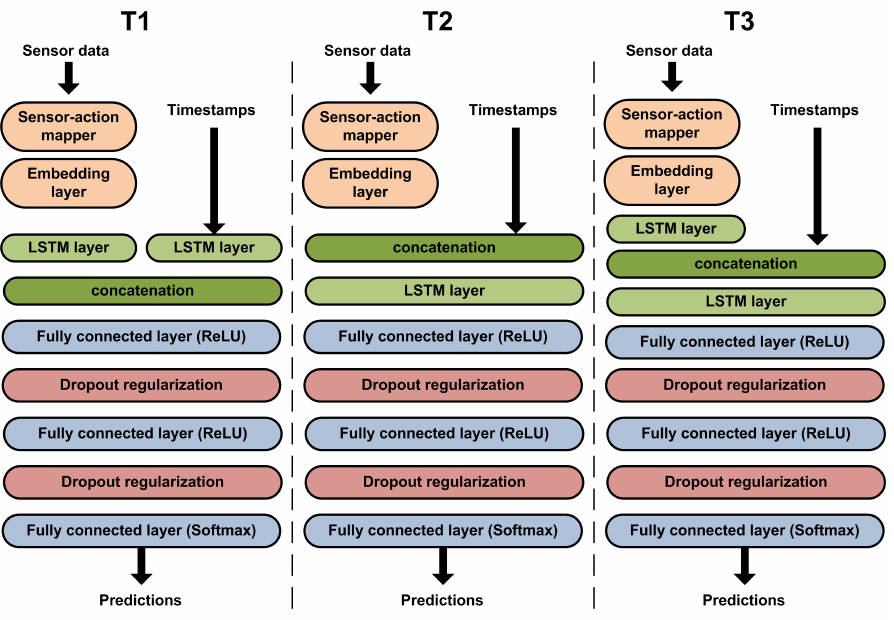
Figure 4. Architectures used in the time experiments. Each of the experiments used a different fusion strategy: T1 used late fusion, T2 used early fusion and T3 used slow